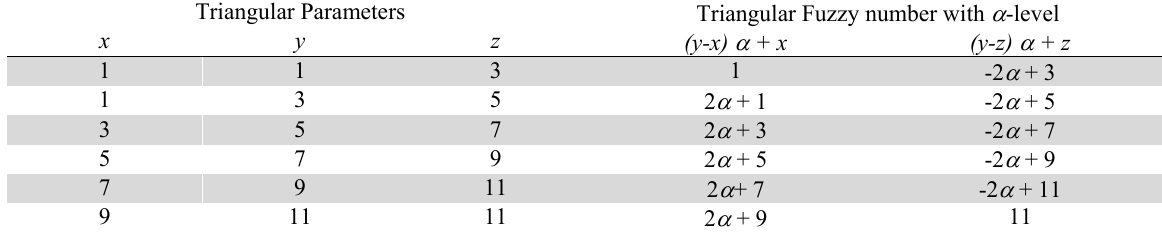
Triangular Fuzzy Number Predefined Parameters